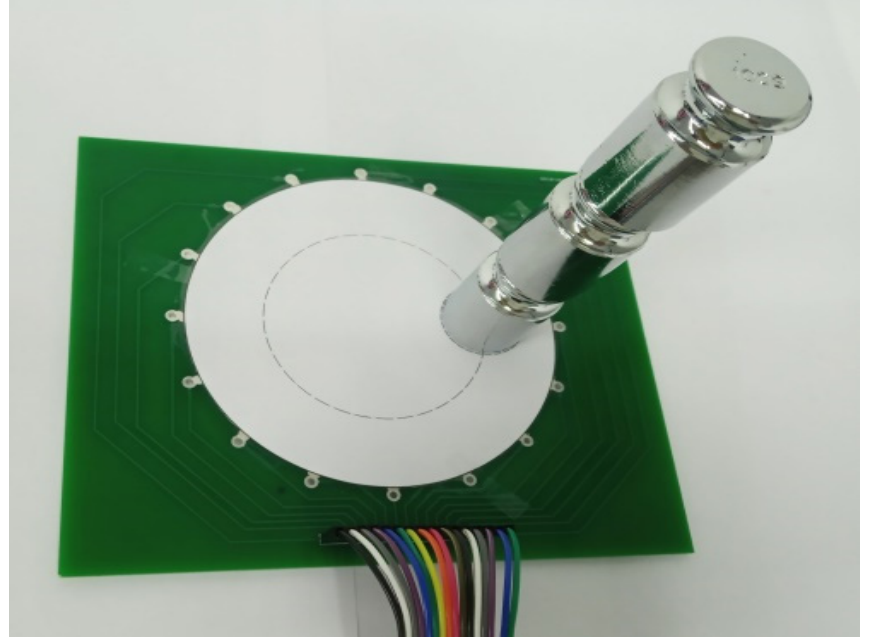
Figure 12. Setup to detect the relationship between pressure and the value color bar.